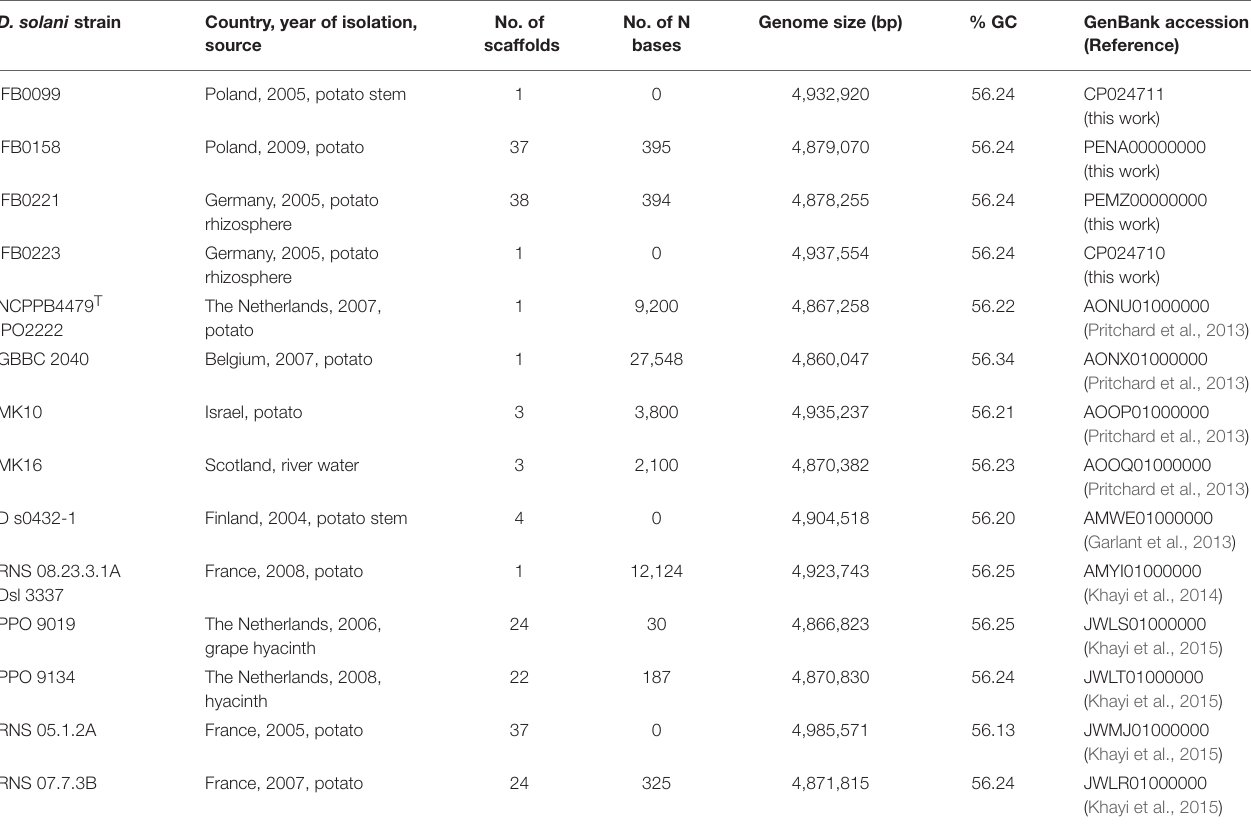
TABLE 1 | Bacterial strains used in this study and their genomic